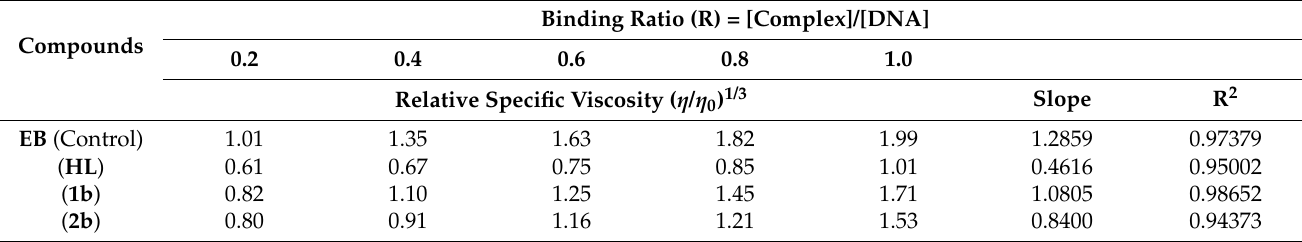
Figure 4. ( a ) DNA thermal denaturation profile at 260 nm in the absence and presence of ligand ( HL ) and complexes ( 1b – 2b ) in 5 mM Tris-HCl/50 mM NaCl buffer pH = 7.2, [DNA]/[Complex] = 1(R), the denaturation temperature (T m ) was taken as the mid-point of the hyperchromic transition. ( b ) The derivative melting curve for DNA thermal denaturation at 260 nm in the absence and presence of compounds in 5 mM Tris-HCl/50 mM NaCl buffer pH = 7.2, [DNA]/[Complex] = 1(R). Table 2. The thermodynamic profiles of electronic absorption spectra for the binding of ligand ( HL ) and its complexes ( 1b – 2b ) to CT–DNA. Table 3. The relative specific viscosity vs.